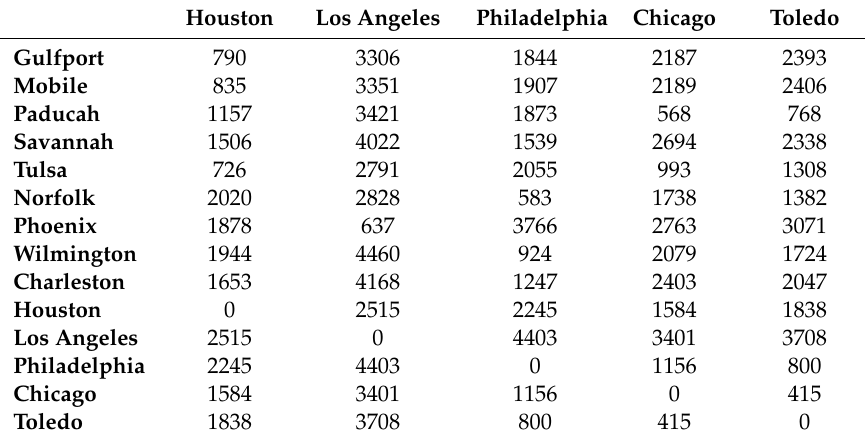
Table A12. Pipeline distances between Transesterification and Demand locations